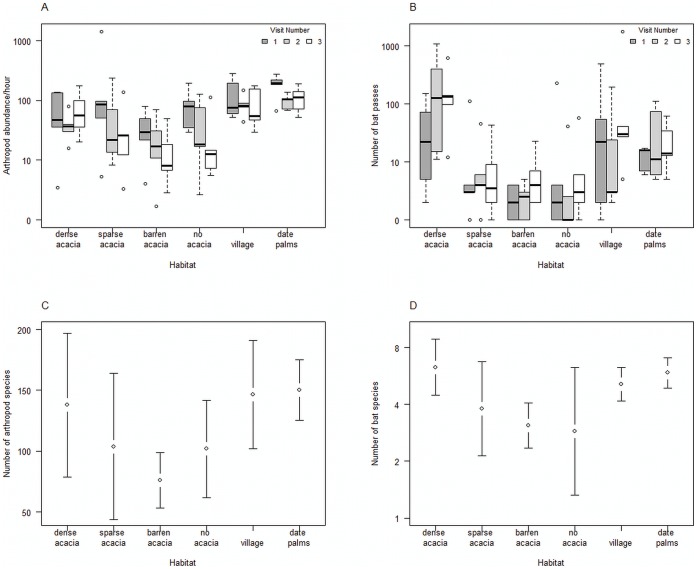
Arthropod abundance, bat activity and species richness for each habitat.
a: box plot of arthropod abundance per hour for three consecutive repeats (visits). b: box plot of total number of bat passes for three consecutive repeats (visits). c: total number of arthropod morphospecies (mean ± standard deviation. d: total number of bat species recorded (mean ± standard deviation).